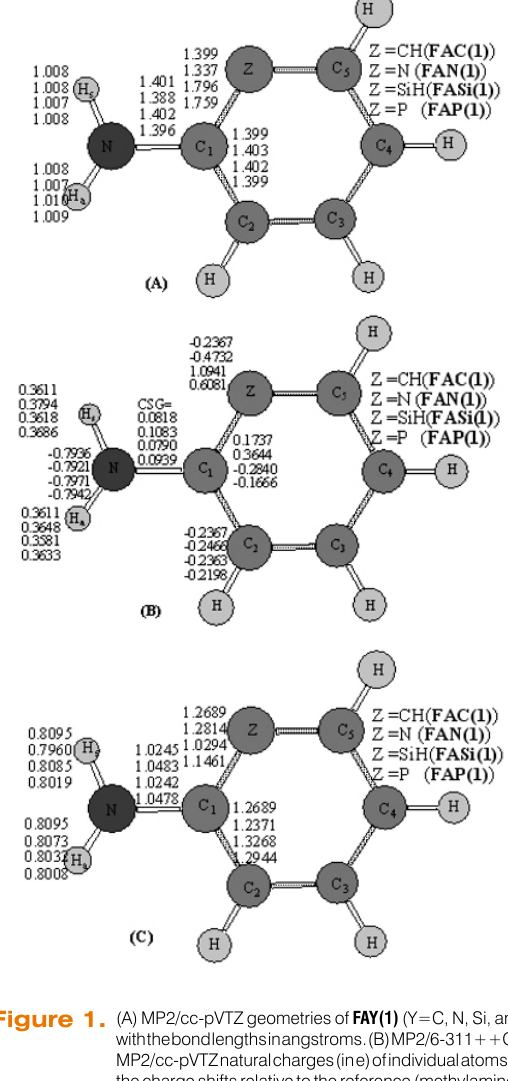
Figure 1. (A) MP2/cc-pVTZ geometries of FAY(1) (Y=C, N, Si, and P) with the bond lengths in angstroms. (B) MP2/6-311++G**// MP2/cc-pVTZ natural charges (in e) of individual atoms, and the charge shifts relative to the reference (methylamine) on amino groups (CSG). (C) MP2/6-311++G**//MP2/cc-pVTZ